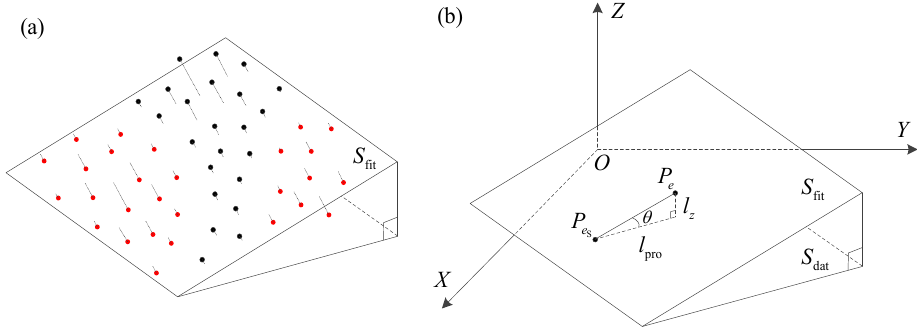
(where is the total number of